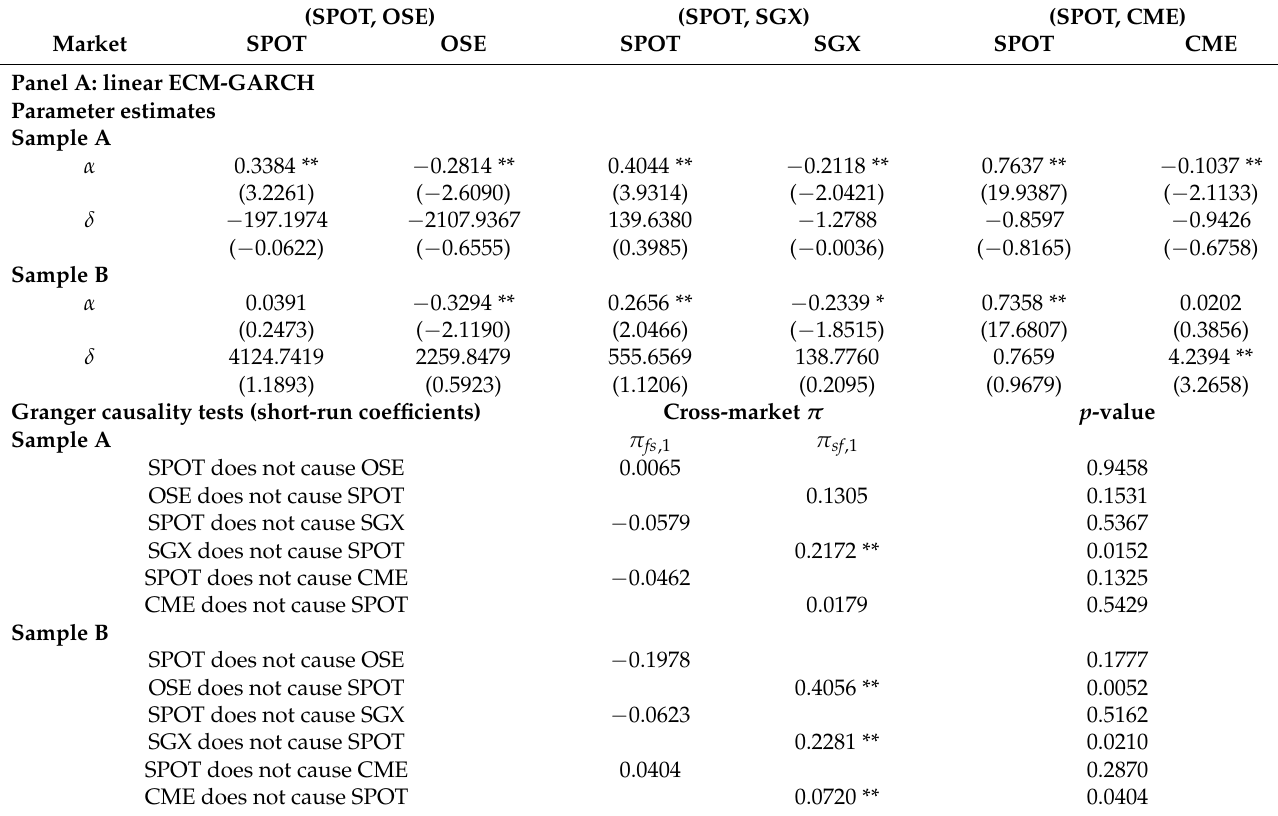
Table 6. Spot–futures price dynamics with